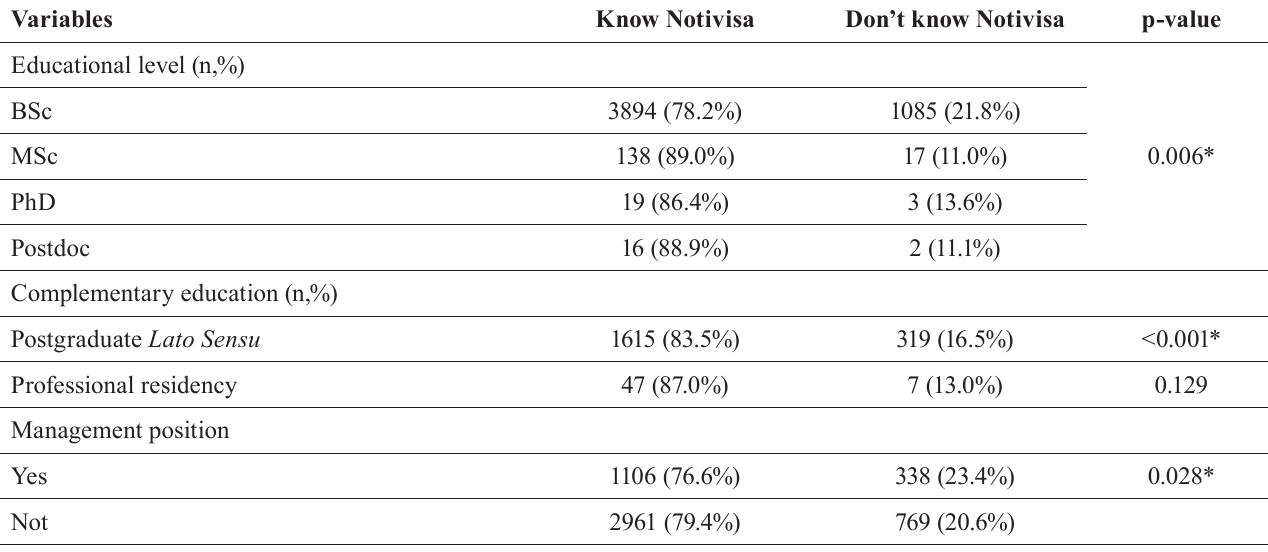
TABLE III - Association between Notivisa’s knowledge and sociodemographic variables